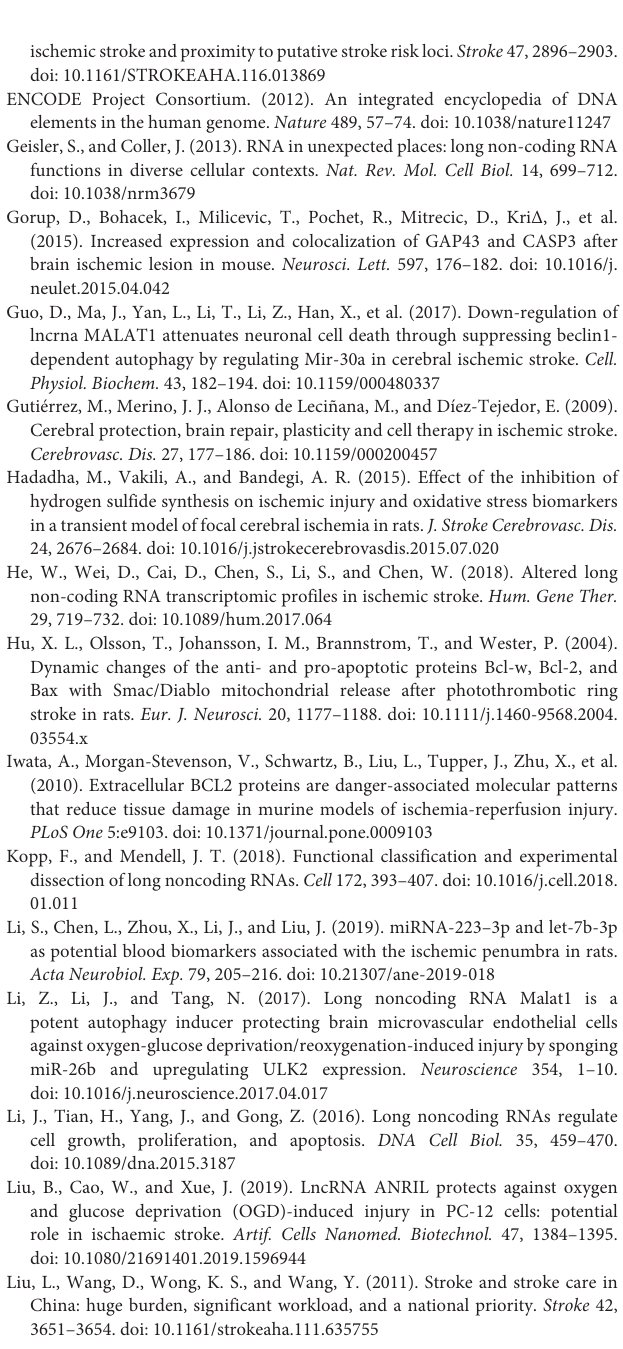
TABLE S1 | Results of statistical analysis. TABLE S2 | Differentially expressed lncRNAs between AIS patients and healthy controls.